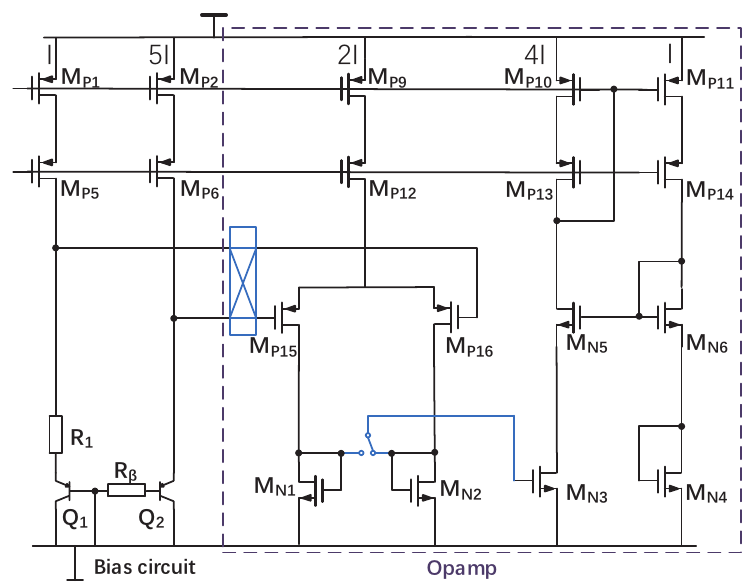
Figure 5. Circuit diagram of opamp with simplified circuit diagram of the bias